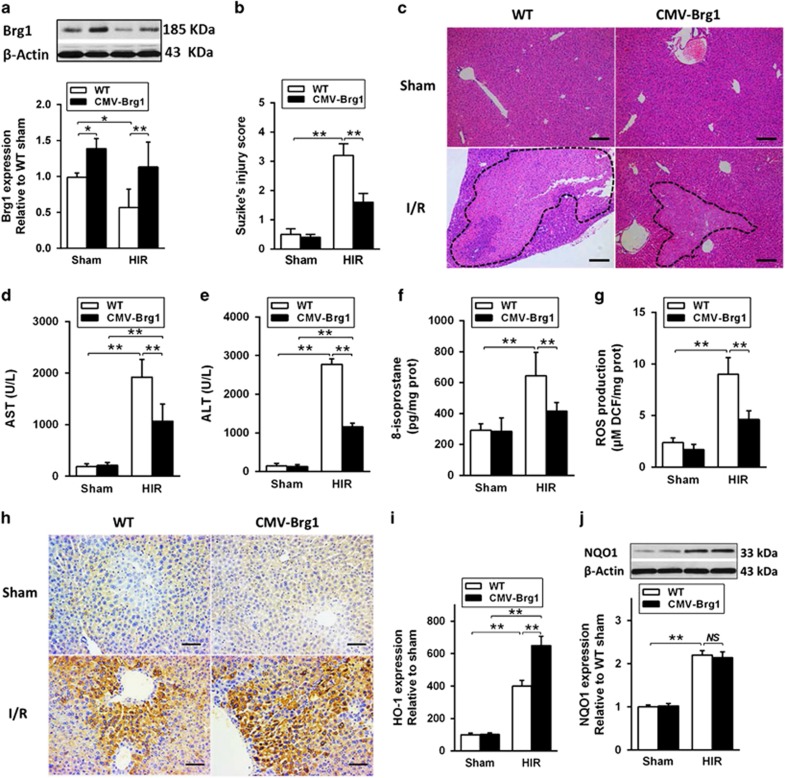
Overexpression of Brg1 attenuated HIR injury via enhancing antioxidant enzyme. Animals were subjected to 70% liver warm ischemia for 60 min and live tissues were collected at 6 h after reperfusion. (a) Western blot analysis showed that Brg1 expression was increased in Brg1 overexpression (CMV-Brg1) mice compared to WT mice both in the sham and HIR groups. (b) Suzike’s injury score showed lower scores in CMV-Brg1 mice than in WT mice after HIR injury. (c) Representative H&E staining images of liver collected from WT and CMV-Brg1 mice in the sham and HIR groups are shown. (d and e) Serum AST and ALT concentration showed an improved liver function in CMV-Brg1 mice after HIR injury. (f) ELISA analysis showed elevation of 8-isoprostane level was attenuated in CMV-Brg1 mice in response to HIR injury relative to that in the control. (g) ROS production measured by fluorescence intensity of DCF was reduced in CMV-Brg1 mice after HIR injury. (h) Immumohistochemical staining showed that liver HO-1 protein expression was elevated in response to HIR in CMV-Brg1 mice. (i) Quantitative analyses of the results from h were also performed. (j) Western blot analysis showed that liver NQO1 protein expression did not significantly change in CMV-Brg1 mice compared to WT mice. Each bar represents the mean±S.E.M. (n=6 per group). *P<0.05, **P<0.01, one-way ANOVA with Tukey test. Imaginary line indicated the edge of apoptosis liver tissue